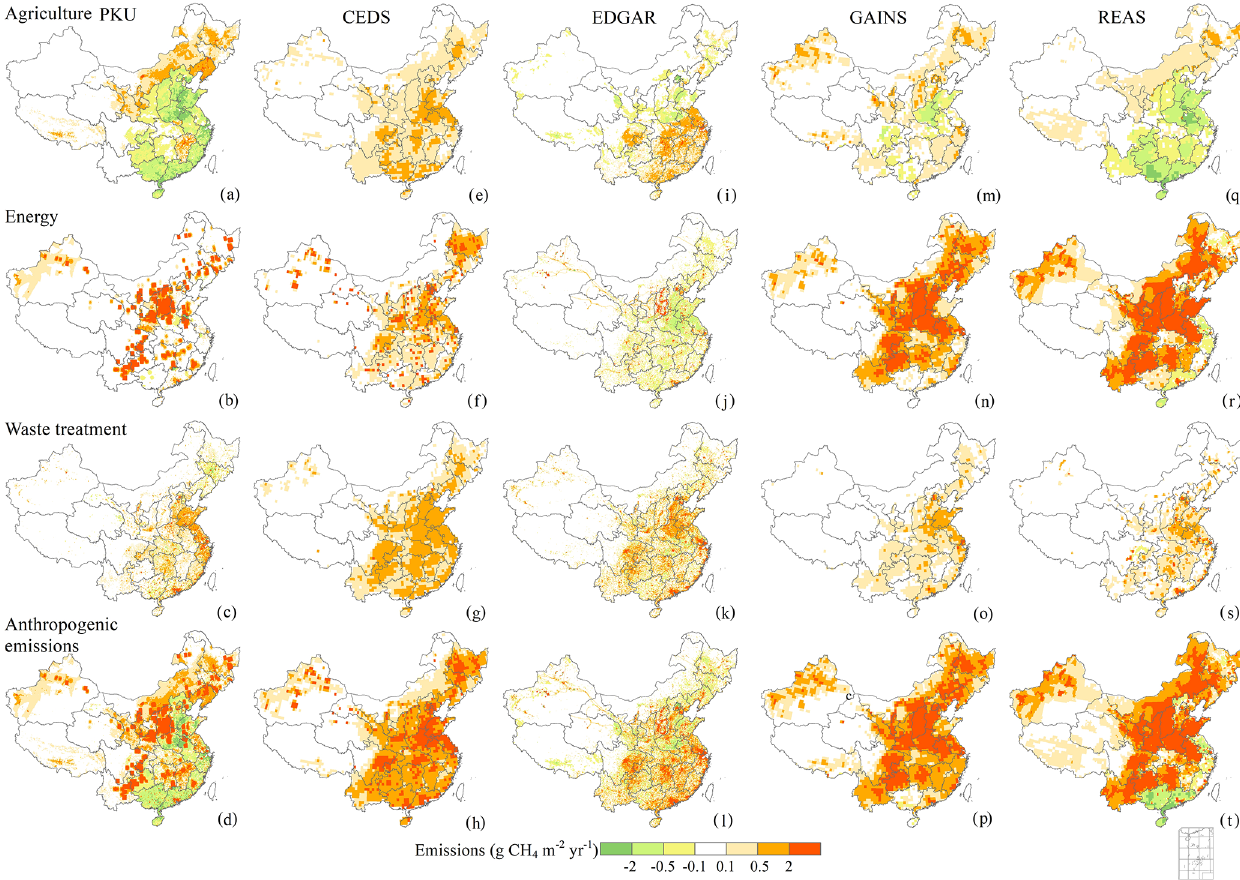
Figure 4. Changes in sectoral and total anthropogenic CH 4 emissions from PKU (a–d) , CEDSv2017-05-18 (e–h) , EDGAR v5.0 (i–l) , GAINS (m–p) from 2000 to 2010, and REAS (q–t) from 2000 to 2008.